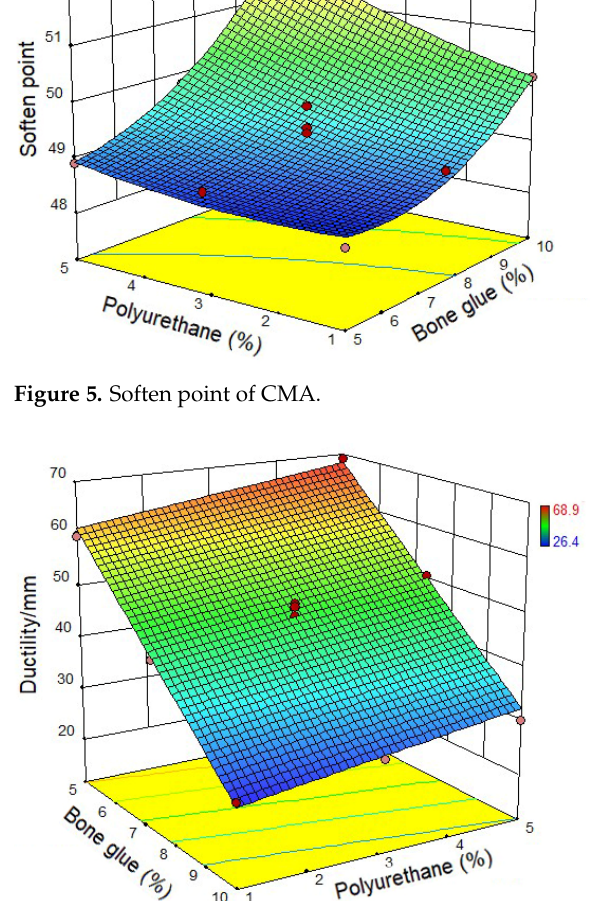
Figure 6. Ductility of composite modified asphalt.